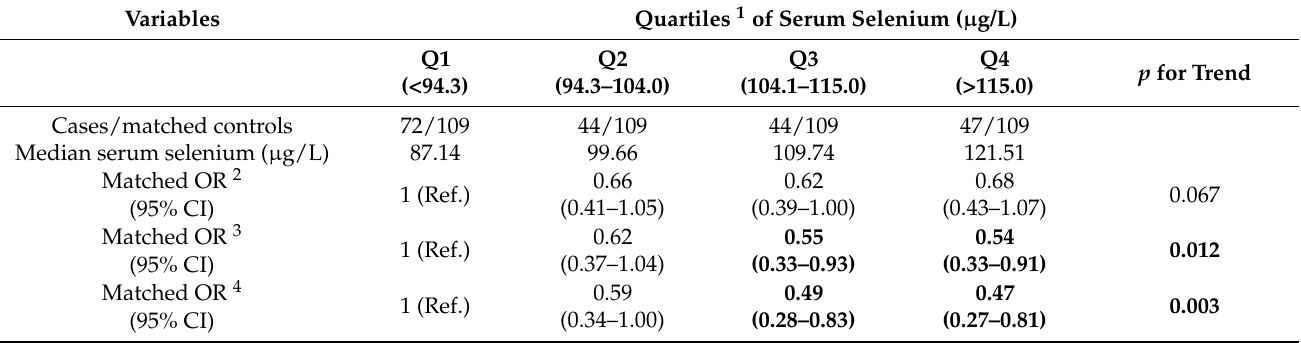
Table 3. Adjusted odds ratios for cardiovascular disease by quartiles of serum selenium. PREDIMED